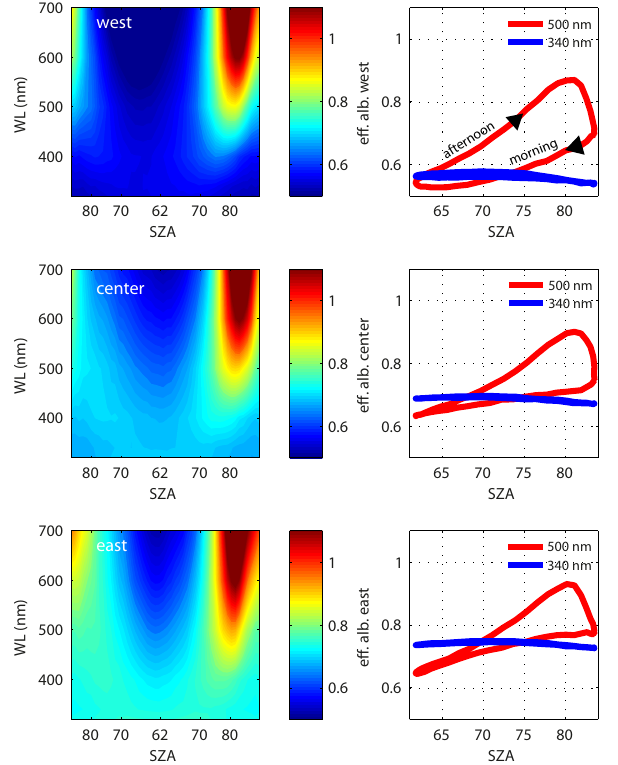
Figure 6. The effective albedo of stations west, center and east as a function of SZA and wavelength. The sun glint causes an increased albedo at high SZA and wavelengths, especially at station west. The right panels show slices at the two wavelengths 340 and 500nm. Effective albedos at 340nm are constant to within 0.02 over the day.